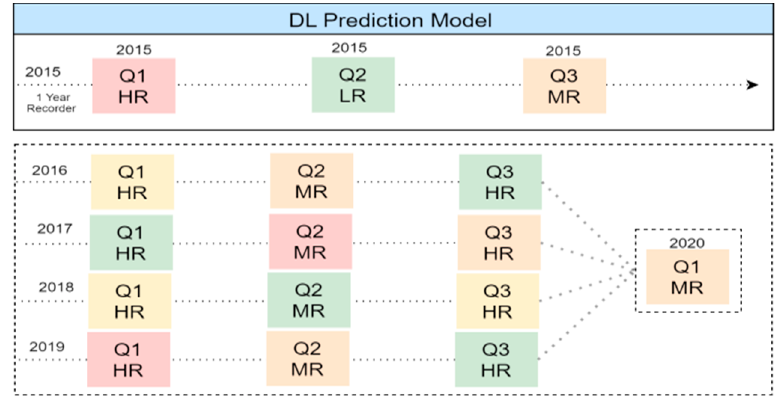
Figure 10. The visualization of top driver’s violations records.